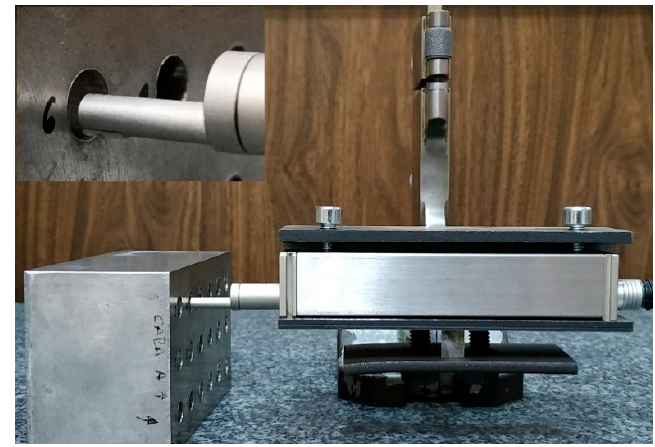
Figure 4. Zeiss Handysurf E-35A roughness tester, positioning system, and probe tip.